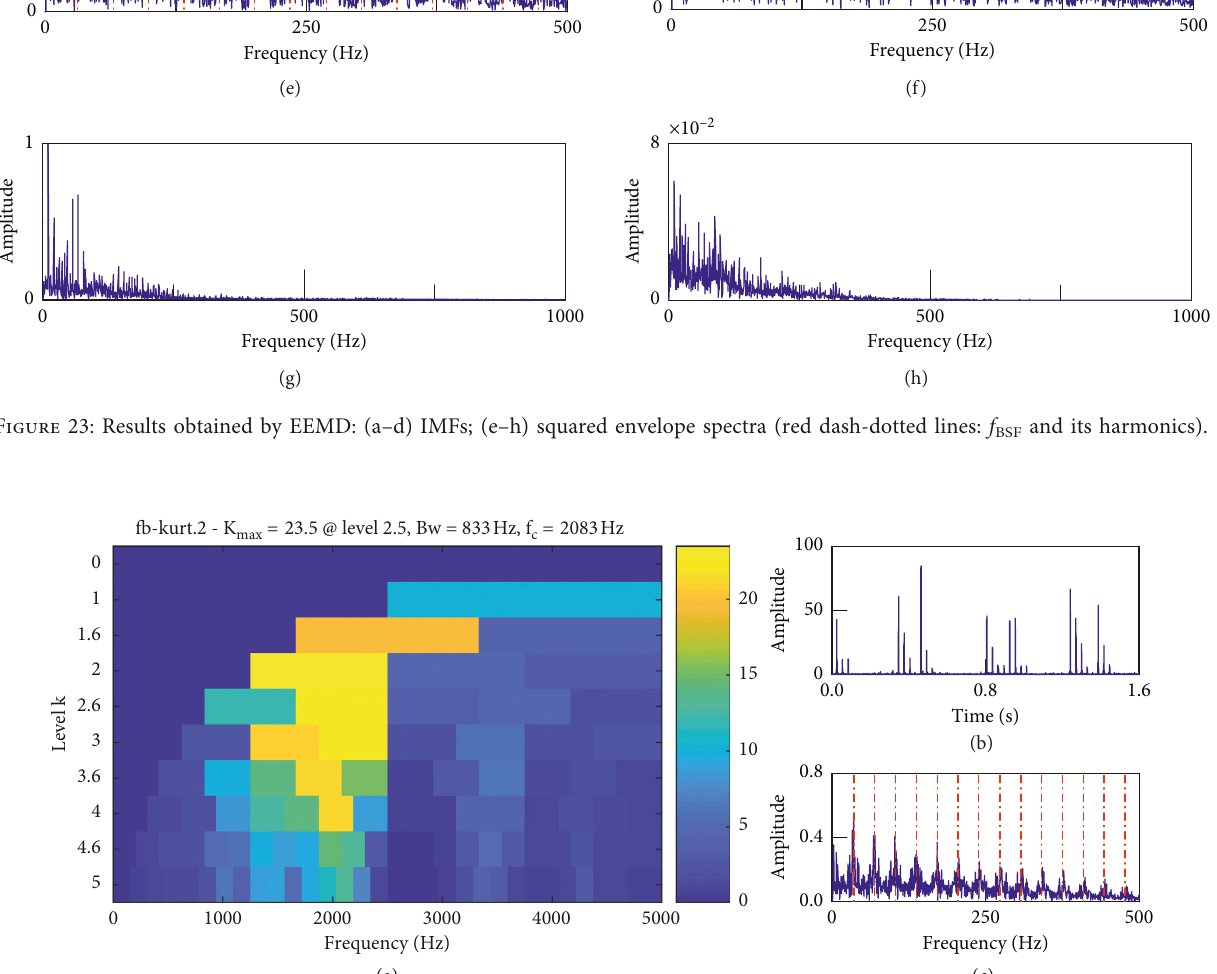
Figure 24: Results obtained by the fast kurtogram: (a) kurtogram; (b) squared envelope of the node with the largest kurtosis value; (c) squared envelope spectrum of (b) (red dash-dotted lines: f BSF and its